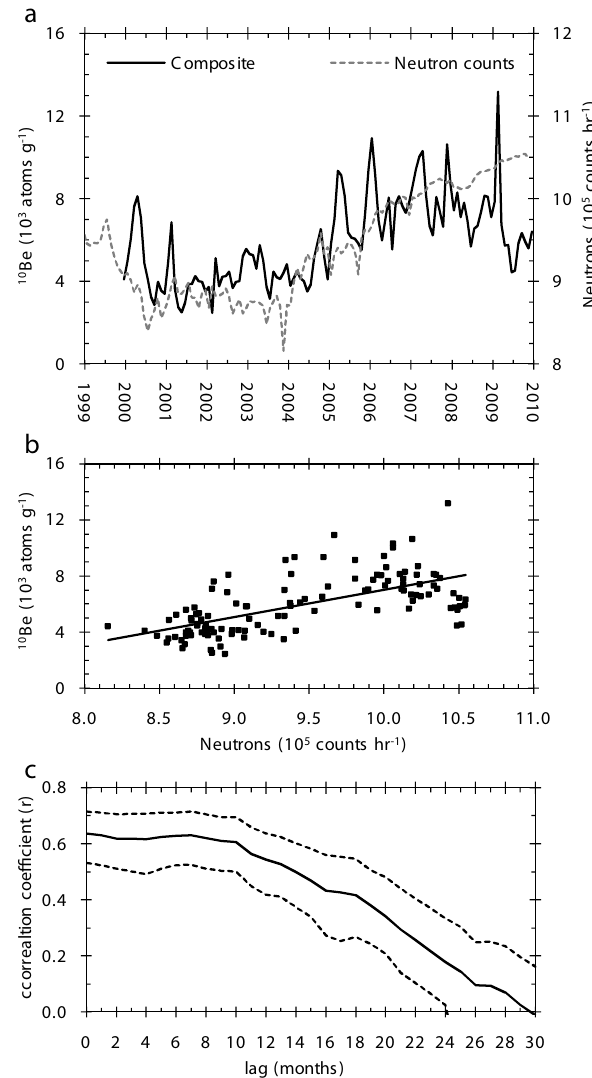
Fig. 5. The relationship between 10 Be concentrations in the DSS composite record and the neutron counting rate on the McMurdo neutron monitor, Antarctica. (a) , Concentrations of 10 Be (black line) compared to the neutron counting rate (dashed grey line). (b) , Concentrations of 10 Be plotted against the neutron counting rate (at zero lag) with a linear regression line fitted to the data. (c) , The correlation coefficient between 10 Be concentration and the neu- tron counting rate as the lag of 10 Be behind neutron counts is var- ied (black line) and the 95% CI around the correlation coefficient (dashed blacked lines). Measurement errors in 10 Be concentrations are typically < 3%, and timescale errors are ± ( 1 to 2 ) months, er- rors in the neutron counting rate are